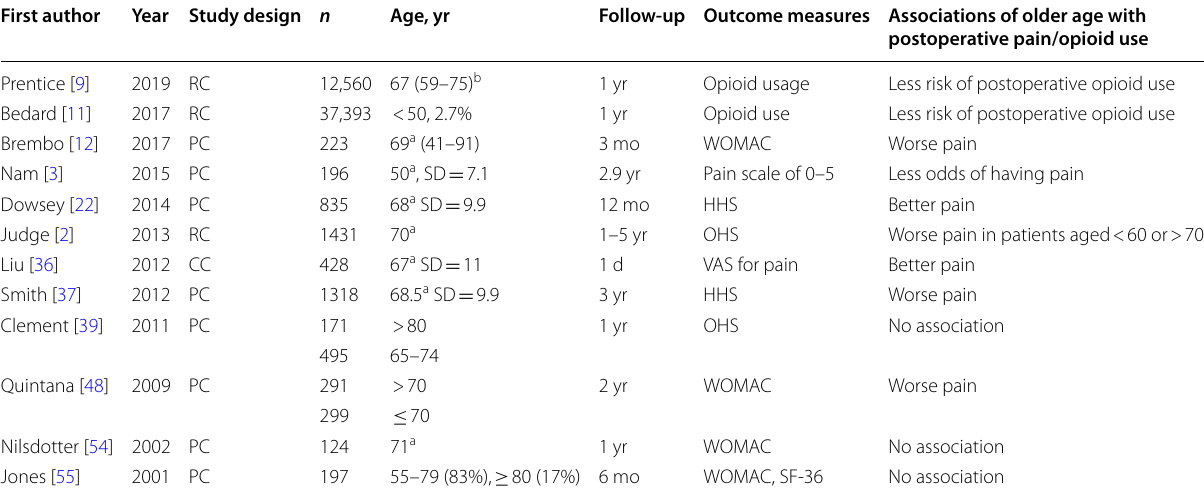
Table 4 Associations of patient age with pain/opioid use after THA